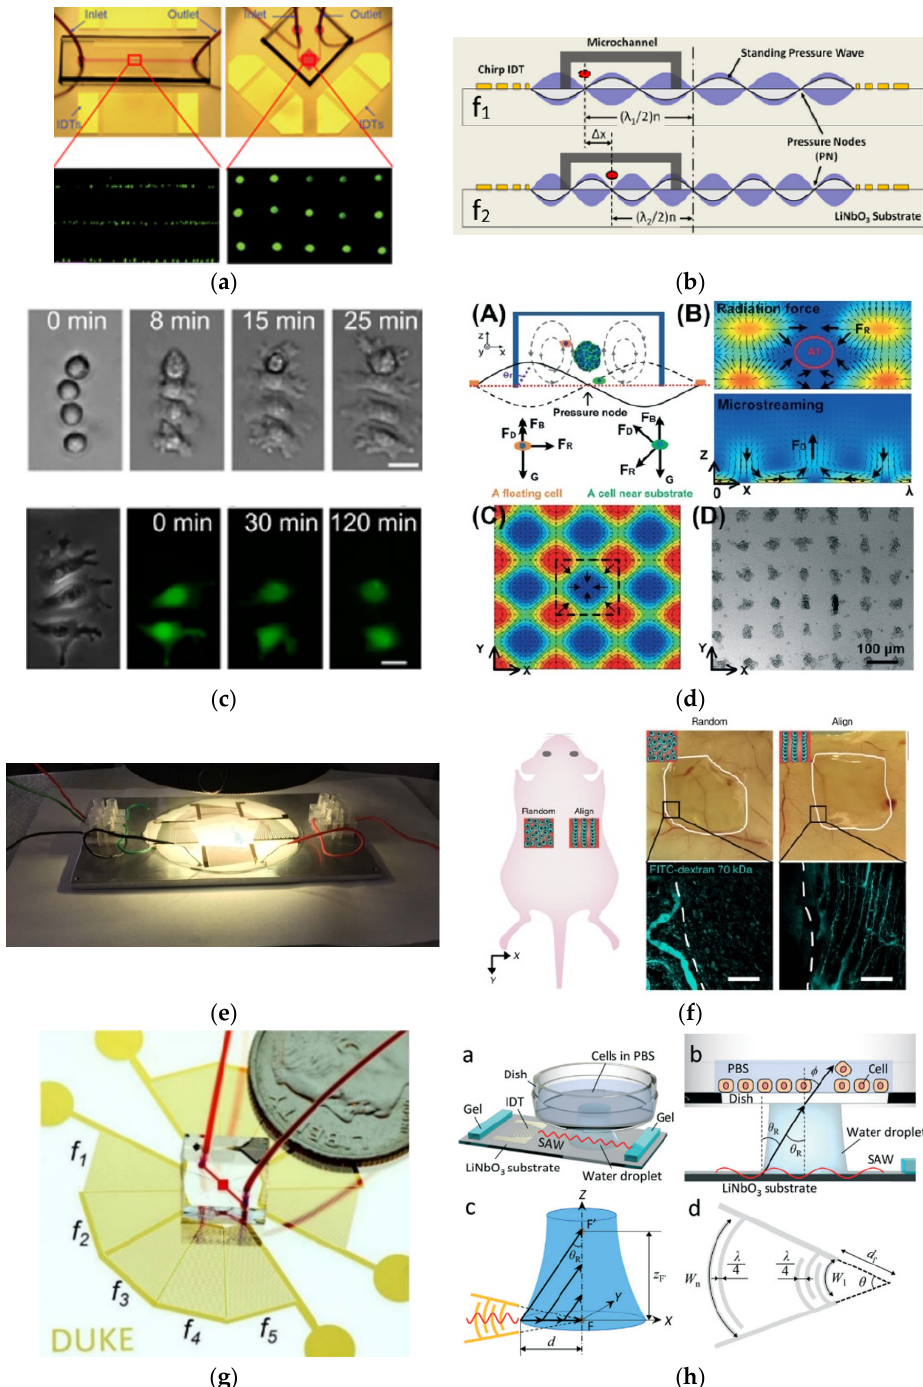
Figure 4. ( a ) SAW devices with a wavelength of 200 µm used in 1D and 2D patterning experiments [25]. ( b ) Driving chirped IDTs at frequencies f1 and f2 produces a standing SAW field [26]. ( c ) Assembly and attachment of HeLa S3 cells and dye transfer between the attached cells [27]. ( d ) Acoustic tweezers were used to produce spheroids above pressure nodes [28]. ( e ) Experiment setup to apply SAW on cells using slanted fingers IDT [29]. ( f ) Comparison between the transplantation of random and aligned cell-hydrogel constructions into the subcutaneous space of the mouse back and the results after 1 week of transplantation [30]. ( g ) A fabricated chip with the spiral shape of IDTs deposited on LiNbO 3 substrate [23]. ( h ) Locally removing cells from a culture surface by using focused IDT using SAW technique [31]. Images reproduced with permission from references